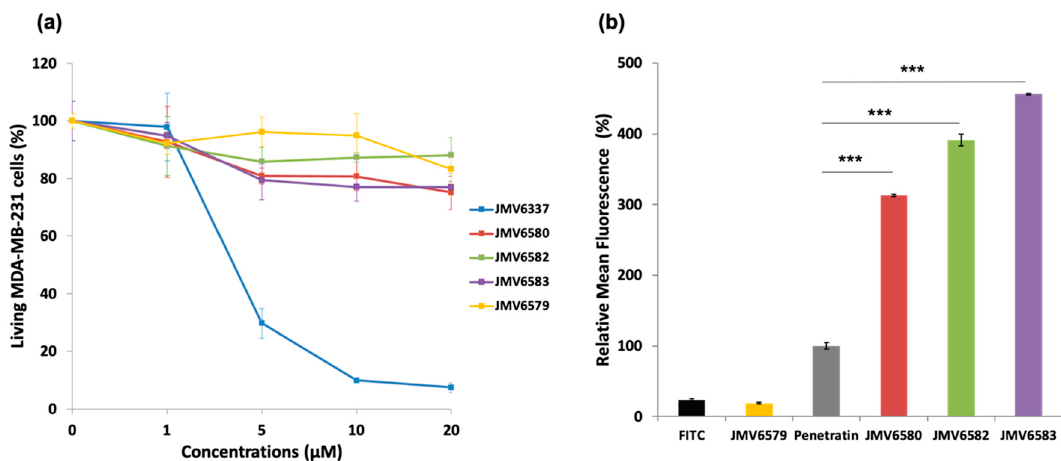
Figure 2. Cytotoxicity and cellular uptake studies of FITC-stapled peptides ( a ) Cytotoxicity study in human breast adenocarcinoma MDA-MB-231 cells incubated with increasing concentrations (from 0 to 20 μ M) of the stapled peptides for 72 h. ( b ) Uptake of FITC-stapled peptides at 5 μ M final concentration in MDA-MB-231 cells after 4 h of incubation represented as relative mean fluorescence. The values are normalized with respect to penetratin. Results are presented as means ± standard deviations of three independent experiments performed in triplicate.